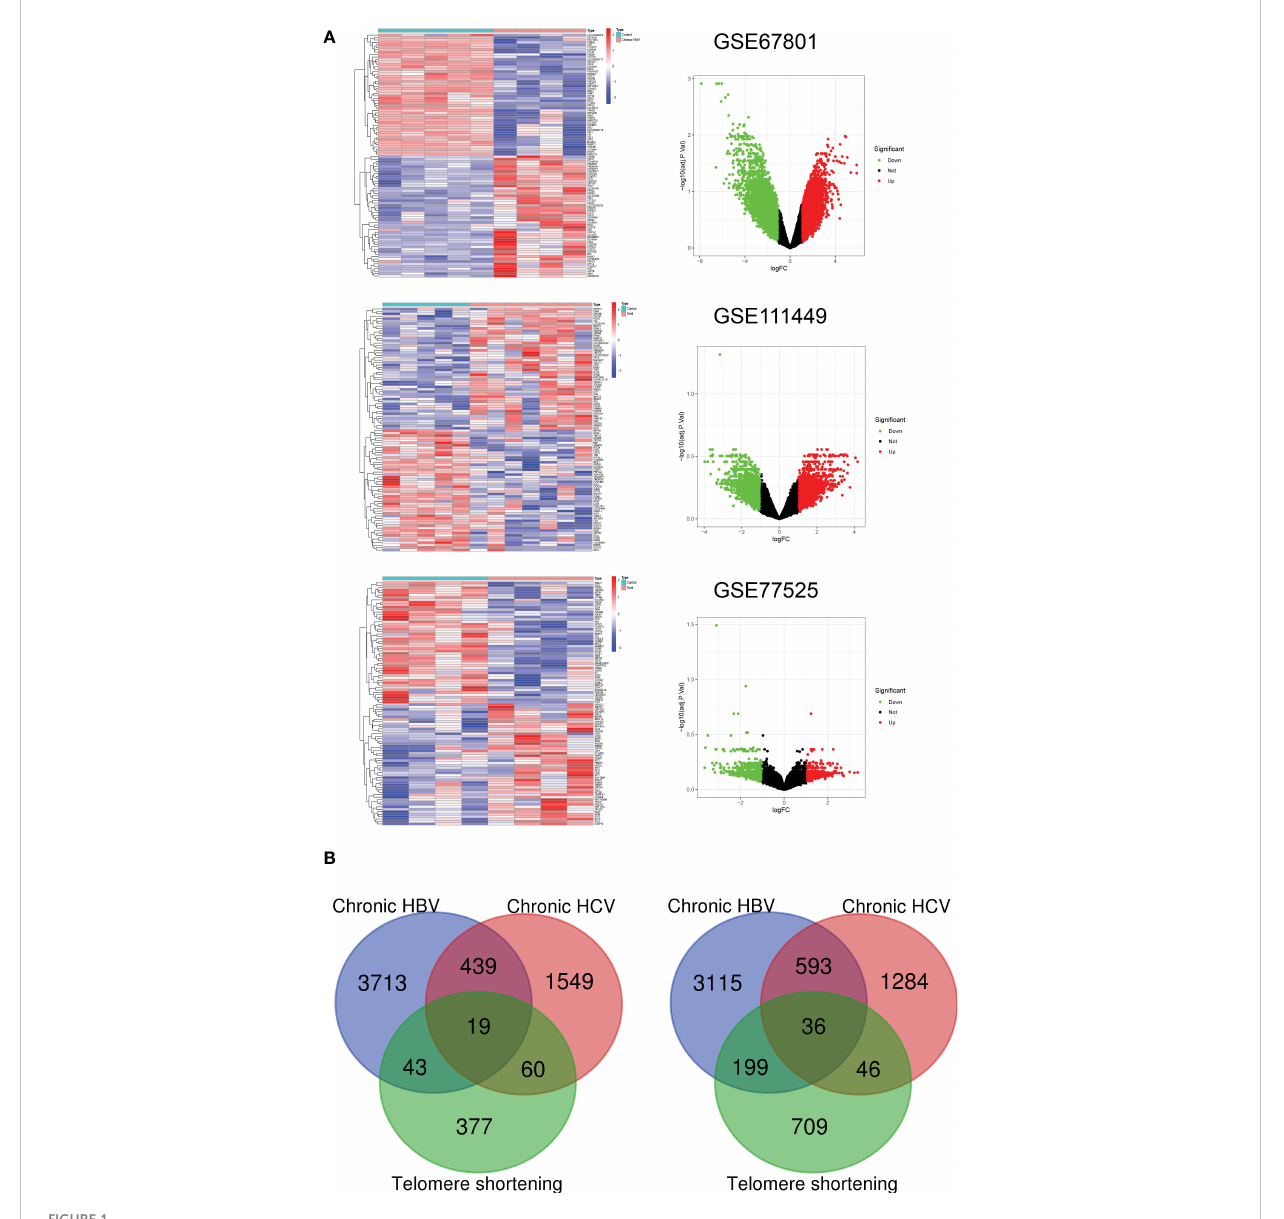
FIGURE 1 Construction of Tex-related gene list. (A) Heatmap and Volcano plot of the DEGs between Tex cells and CD8 T control cells from three GEO datasets. Green represents downregulated DEGs, red represents upregulated DEGs, and black represents no difference. (B) Venn diagram demonstrates the co-upregulated and co-downregulated DEGs for the Tex-related gene